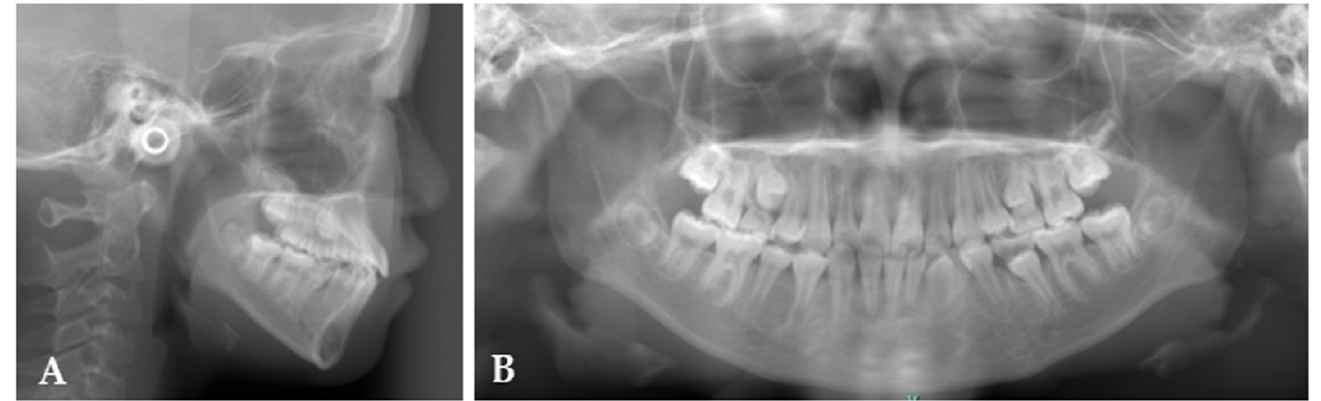
Figure 6. Lateral cephalogram ( A ) and panoramic radiograph ( B ) at 6-month retention. Posttreatment cephalometric evaluation showed a skeletal Class I jaw base relationship (ANB, 0.5°). Concomitantly, Wits value was increased by 2.8 mm. The mandibular plane angle was maintained within the normal range (Mp-SN plane, 34.4°). The upper and lower incisors were labially inclined as compared with pretreatment (U1-SN, 118.0° and L1-Mand. pl., 82.0°) and the interincisal angle was leaded to the normal range (125.6°) (Table 1).